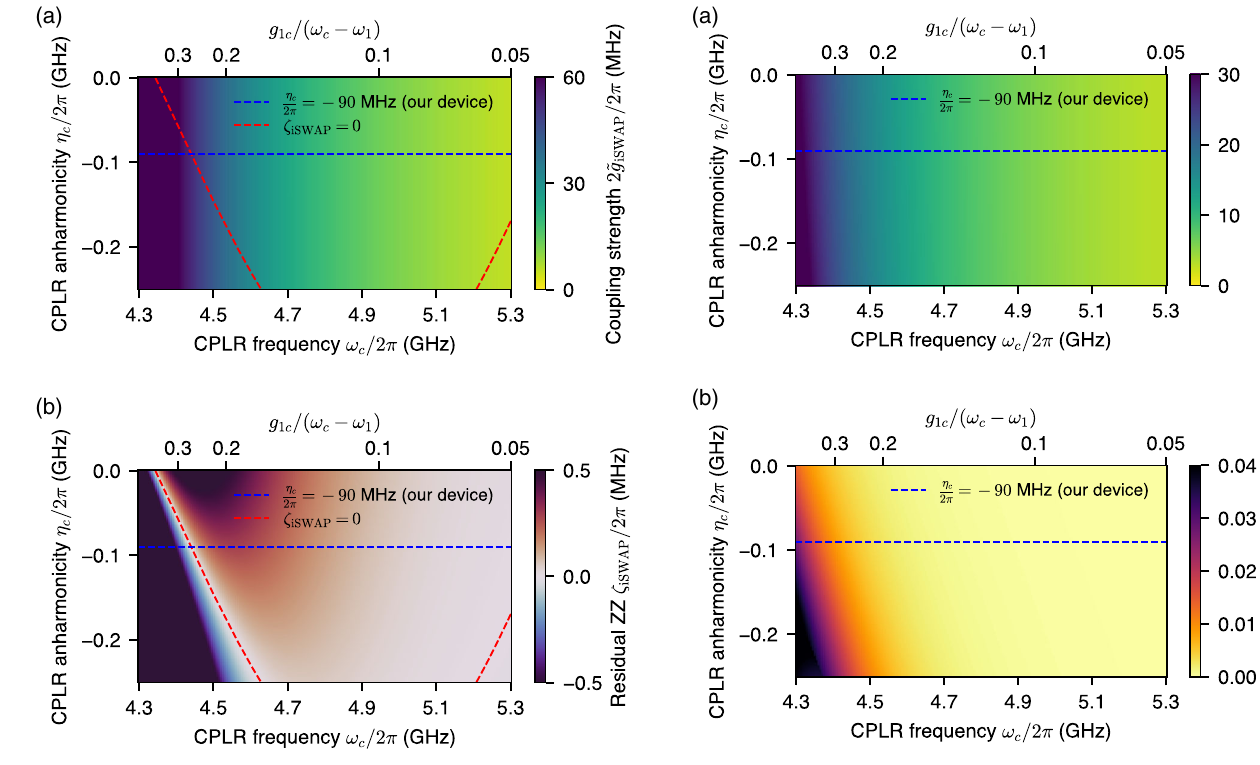
FIG. 21. Numerical simulations of (a) coupling strength ˜ g FIG. 20. Numerical simulations of (a) coupling strength ˜ g iSWAP the CZ interaction and (b) the state overlap jh 020 j g 101 ij 2 þ and (b) residual ZZ strength ζ for an iSWAP interaction iSWAP versus the coupler anharmonicity η ( y axis) and the coupler h 020 j g 200 ij 2 versus CPLR anharmonicity η c ( y axis) and c frequency ω ( x axis), where ω 1 = 2 π ¼ ω 2 = 2 π ¼ 4 . 16 GHz. Note c 0 , that smaller η enables ZZ -free iSWAP interaction ( ζ c iSWAP ¼ red dashed curves) with stronger ˜ g , thereby enabling faster iSWAP ZZ -free iSWAP gates.